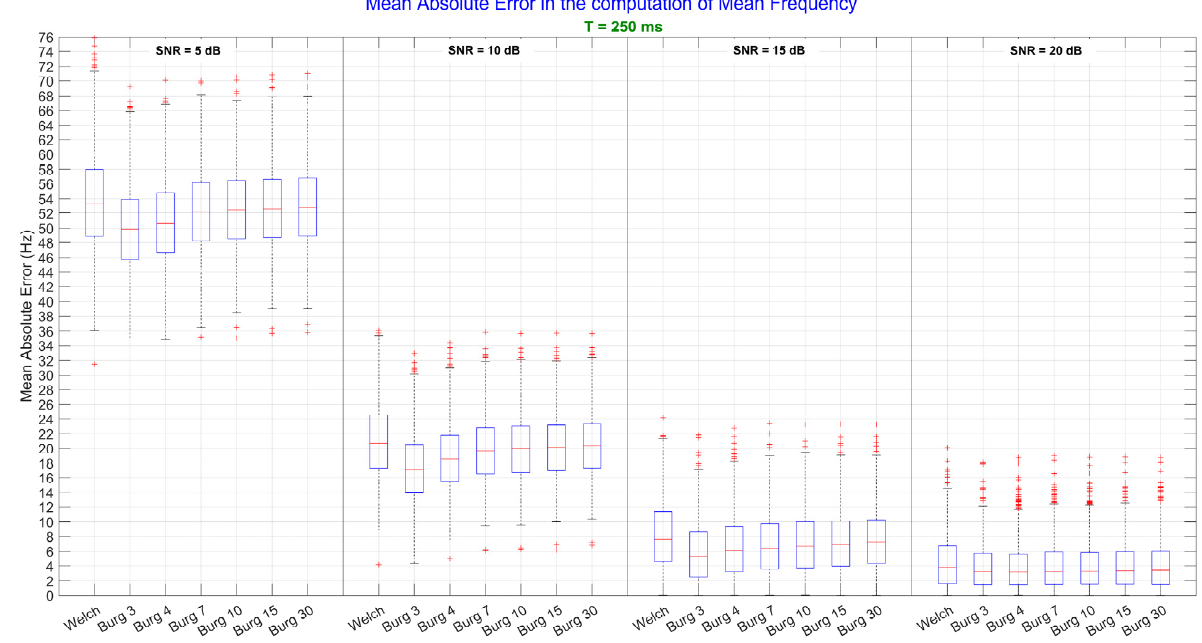
Figure 2. Mean frequency values computed from the power spectral density, which were estimated by Welch and Burg methods. The analysis performed on brief signals (T = 250 ms) is shown. In each subplot, a specific level of Signal-to-Noise Ratio (SNR) is represented. Since one-way ANOVA on the method factor was significant, post-hoc tests were performed: the significance level was set at p < 0.05.